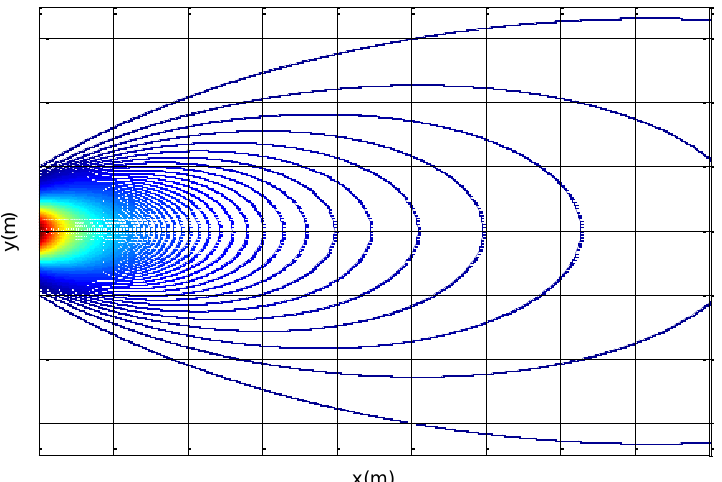
Figure 3. Concentration gradient curves of plume